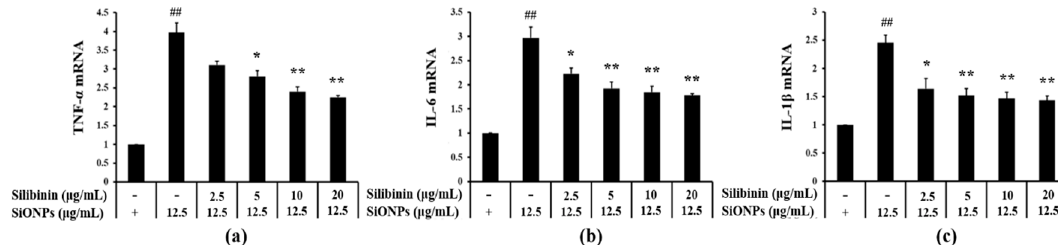
Figure 1. Effects of silibinin treatment on the mRNA expression of proinflammatory cytokines in silica dioxide nanoparticles (SiONPs)-induced NCI-H292 cells as assessed by real-time reverse-transcription polymerase chain reaction (qRT-PCR.) ( a ) mRNA expression of tumor necrosis factor- α (TNF- α ). ( b ) mRNA expression of interleukin (IL)-6. ( c ) mRNA expression of IL-1 β . Data are shown as means ± SD ( n = 3). ## p < 0.01 vs. non-SiONPs-induced NCI-H292 cells, * , ** p < 0.05 and < 0.01 vs. SiONPs-induced NCI-H292 cells, respectively.